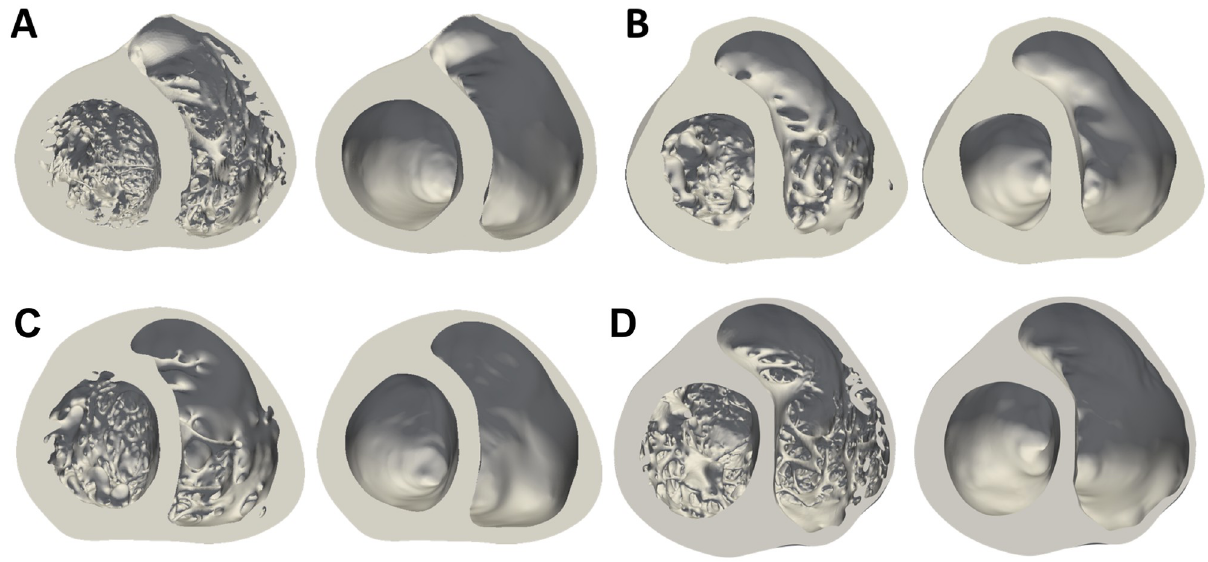
Fig 1. Male ( A-B ) and female ( C-D ) anatomically detailed and corresponding smoothed biventricular geometries. Mid-cavity section.